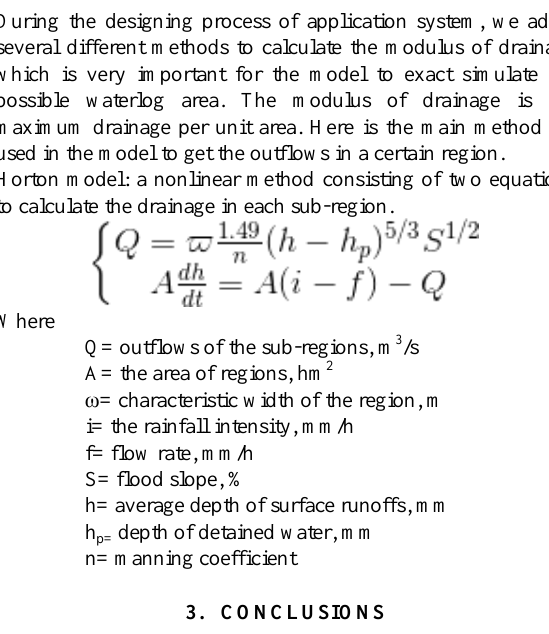
Figure 4. Fields structures